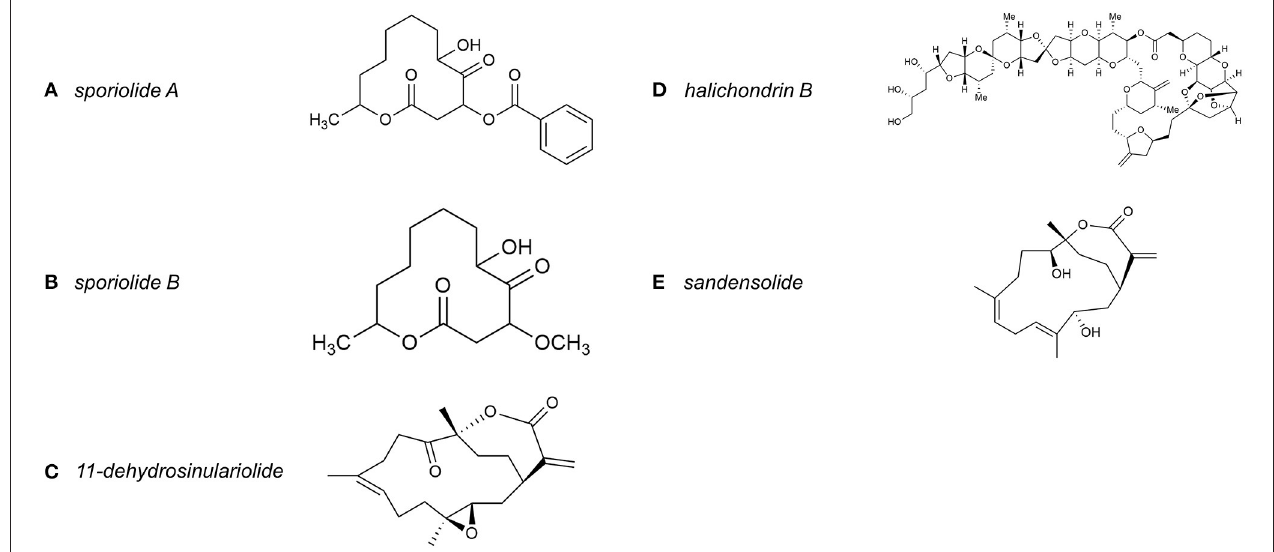
FIGURE 7 | (A–E) The chemical structure of halichondrin B, sporiolide A, sporiolide B, 11-dehydrosinulariolide , and sandensolide